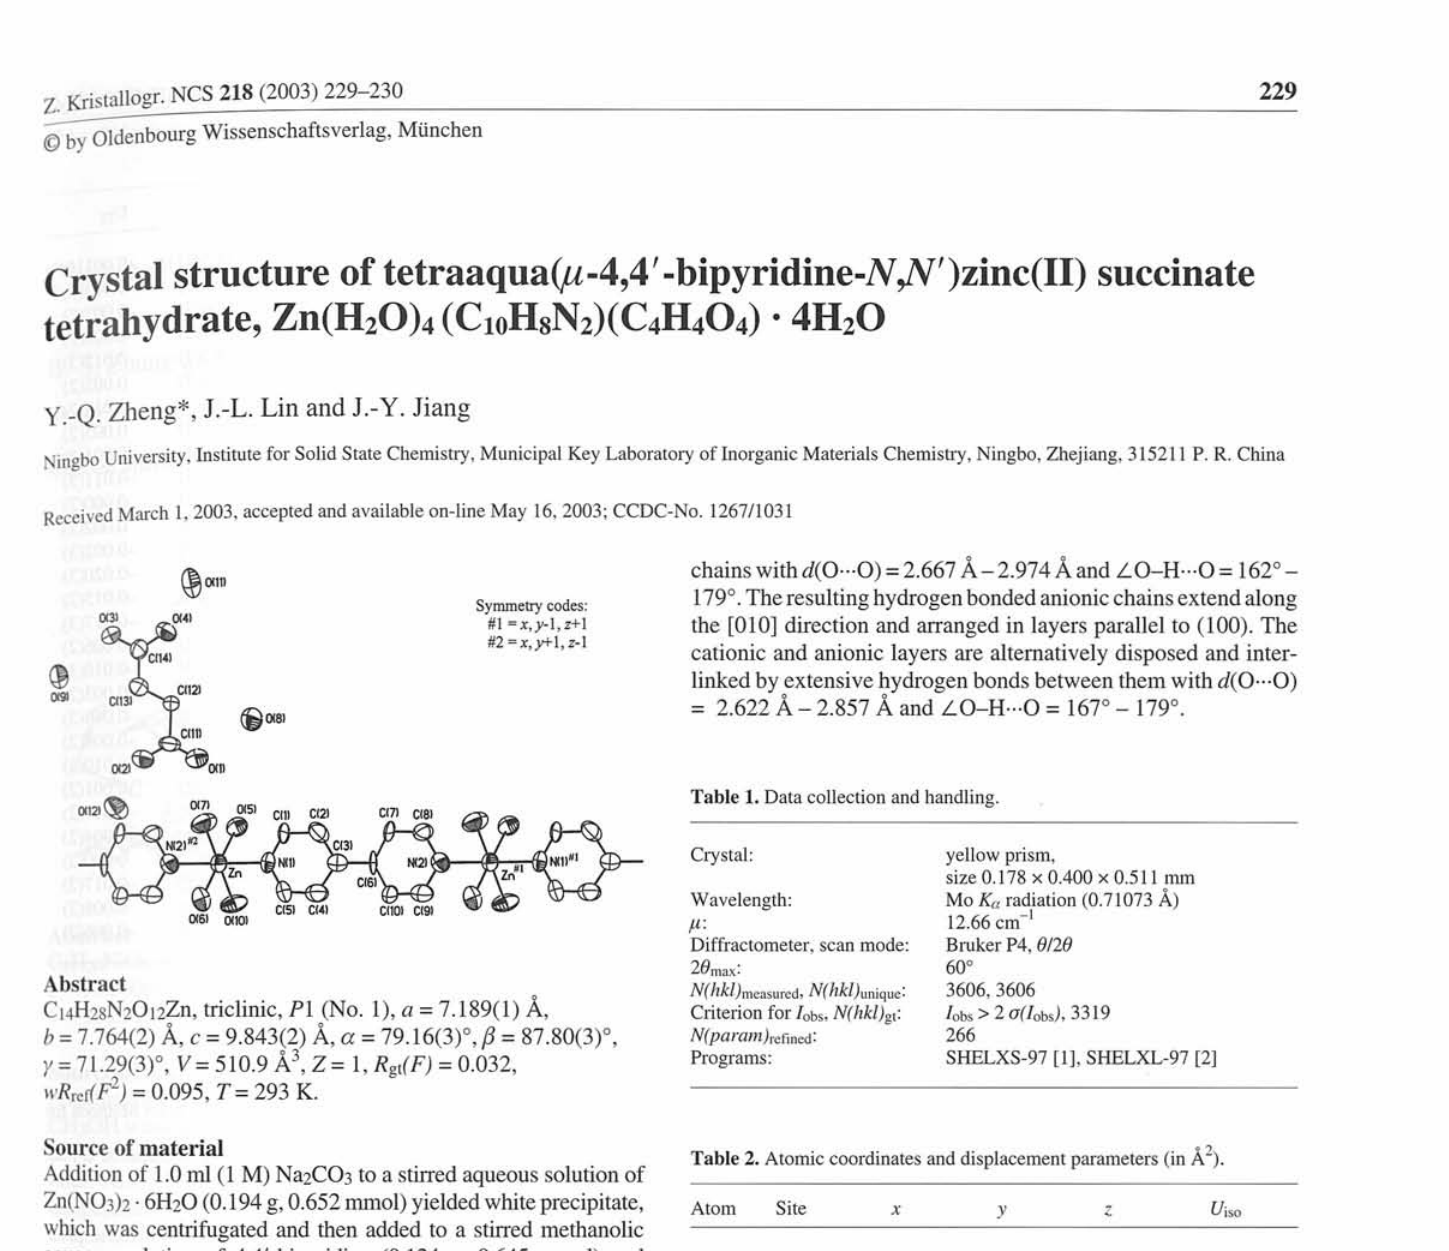
Table 2. Atomic coordinates and displacement parameters (in